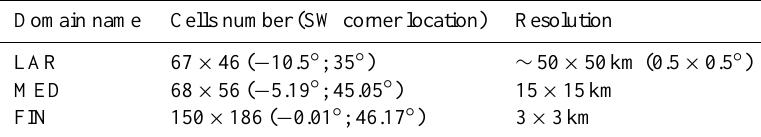
Table 2. Domains description.